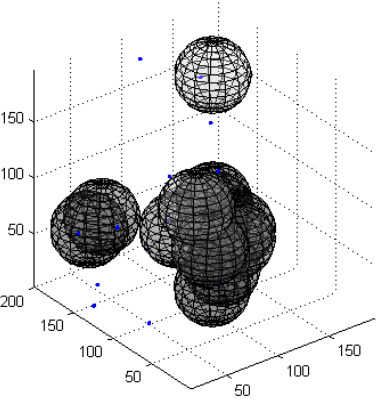
Figure 7. Layout of ineffective nodes in the tenth iteration.